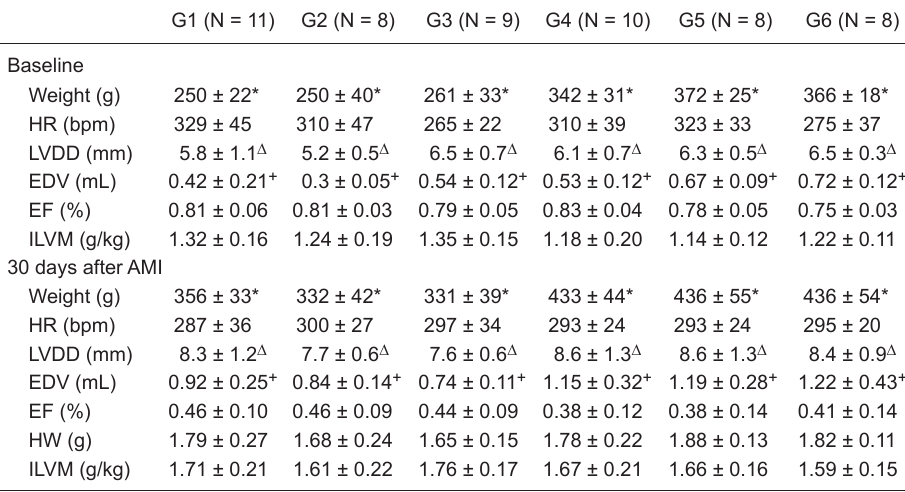
Table 2. Characteristics of the animals in each treatment